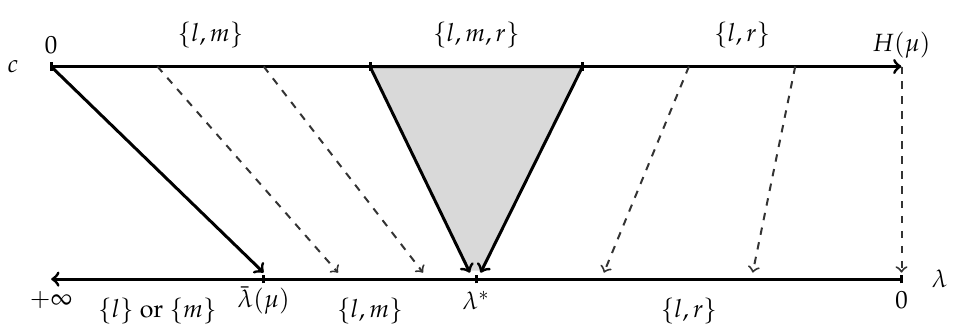
Figure 3. The consideration sets in the solutions of ( (cid:63) ) and ( (cid:63)(cid:63) ) for the case γ ∗ < µ < 0.5, µ (cid:54) = 1 When µ = 1/3, the consideration set in ( (cid:63) ) is { l , m } for every λ > λ ∗ .